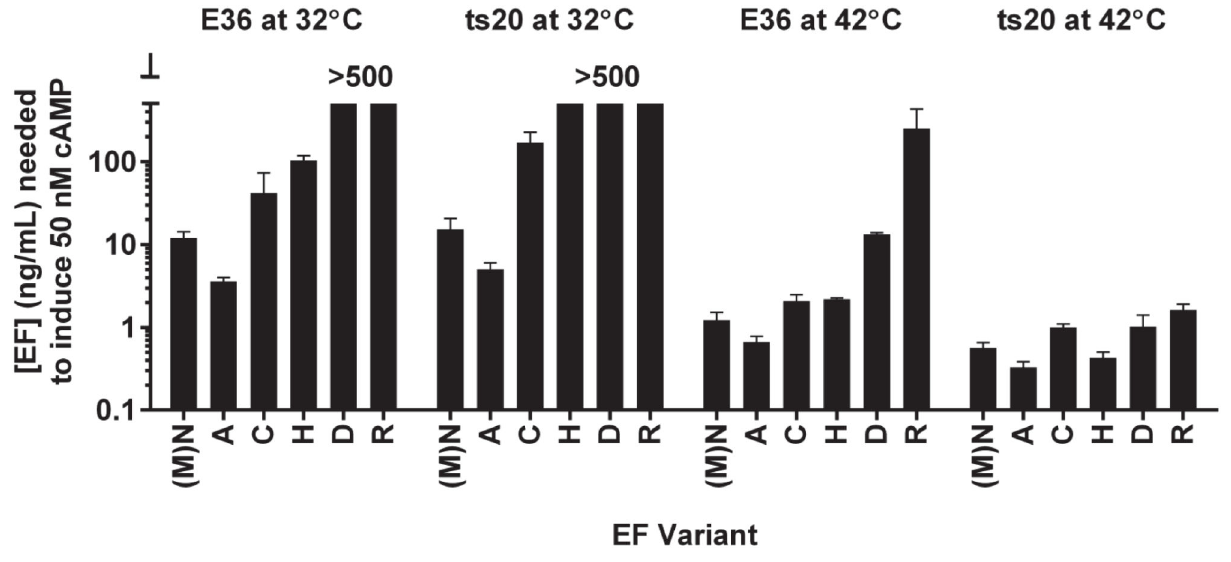
Figure 3. Prevention of ubiquitination enhances cAMP production of destabilized EF variants. E36 and ts20 cells were treated with different concentrations of purified EF N-terminal variants with 500 ng/mL PA at either 32°C or 42°C for 2 h before lysis and cAMP measurement. The concentration of EF estimated to induce 50 nM of cAMP production is presented